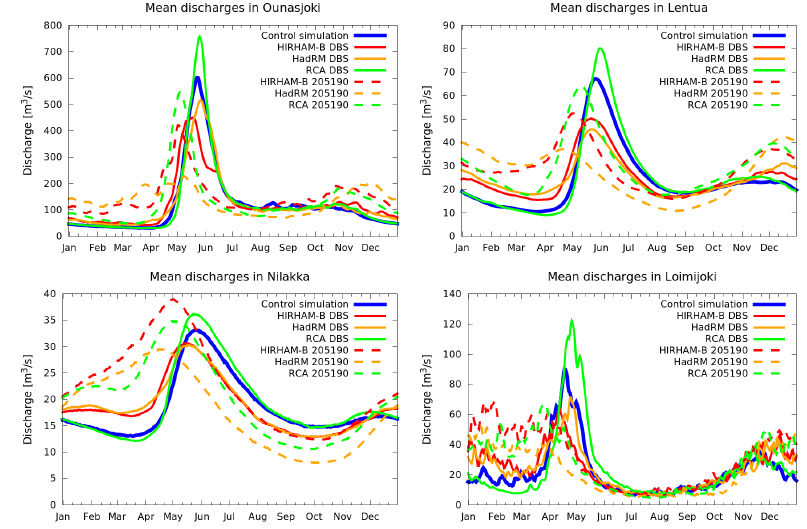
Figure 14. Hydrographs of simulated daily mean discharges with DBS-adjusted temperatures ( T Gaussian without separation) and precipi- tation ( P double gamma) of RCMs in 1961–2000 (solid lines) and in 2051–2090 (dashed lines) compared to control simulation discharges (blue line).